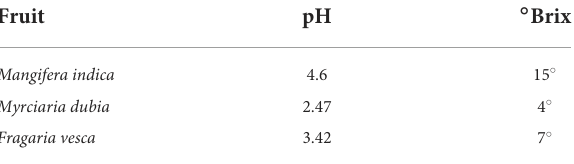
TABLE 3 pH evaluation and sugar content of fruit. Fruit